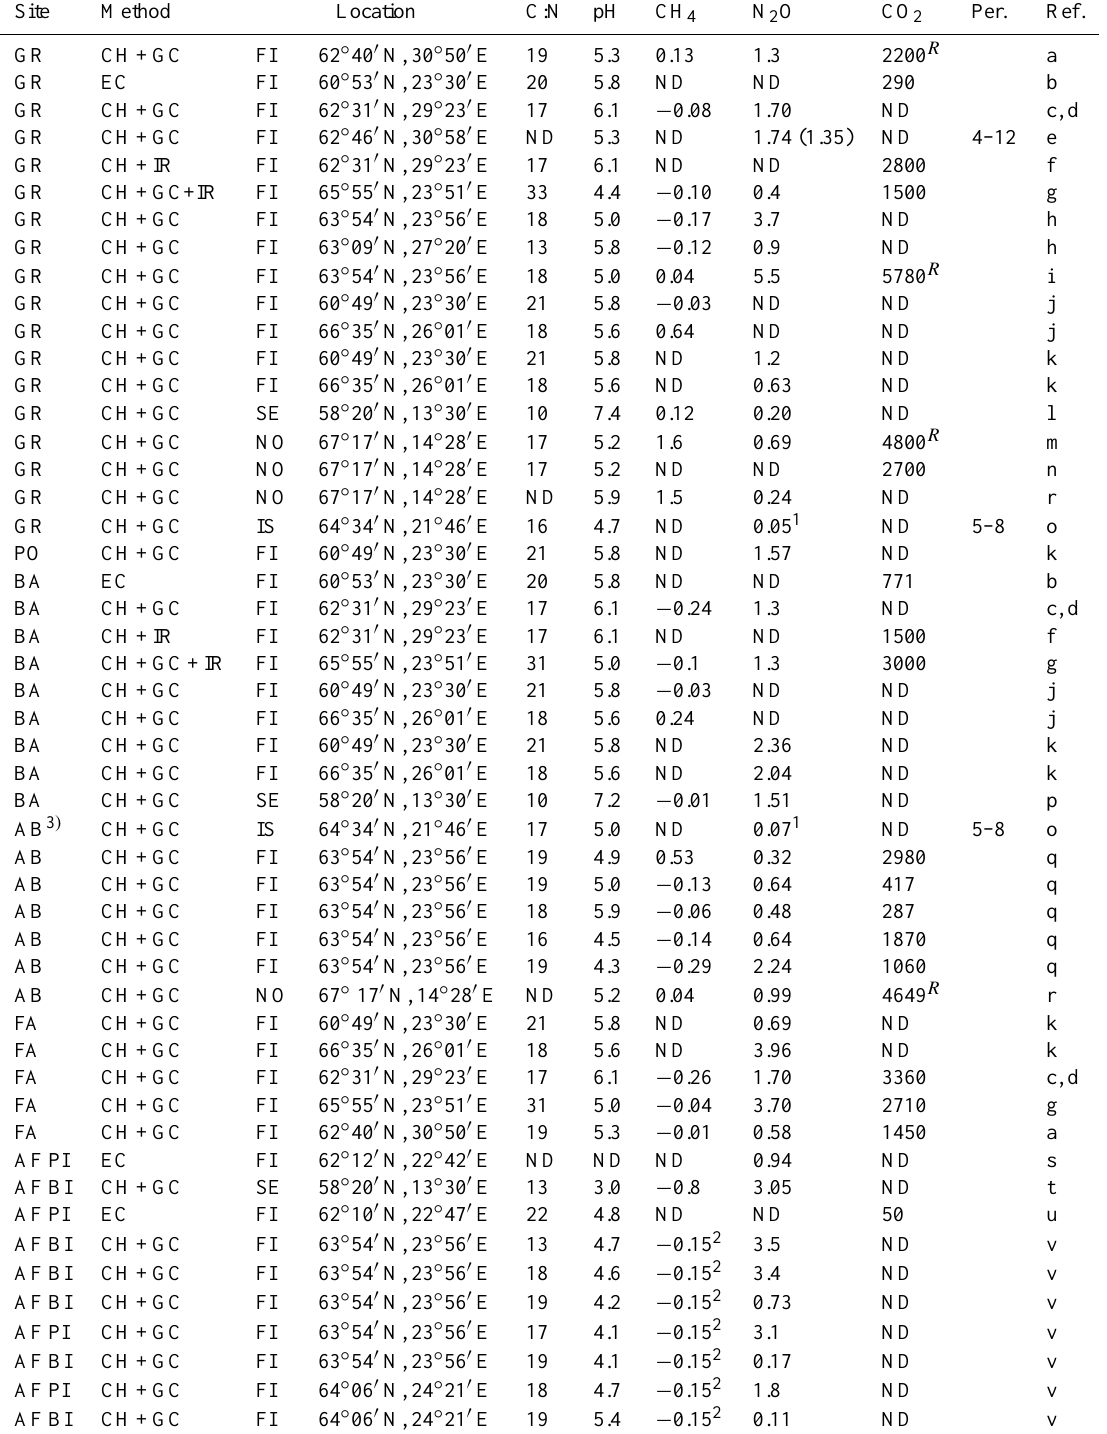
Table 3. Annual emissions of CH 4 (gm − 2 yr − 1 ), N 2 O (gm − 2 yr − 1 ) and net ecosystem CO 2 exchange (gm − 2 yr − 1 , R =only soil res- piration) from drained peatlands used for agriculture (GR=grass, BR=barley, PO=potato, CA=carrot, AB=abandoned with vegetation, FA=fallow without vegetation, AF=afforested with pine – PI – birch – BI – or alder – AL), in the Nordic countries (DK=Denmark, FI=Finland, IS=Iceland, NO=Norway, SE=Sweden). A negative value indicates uptake, a positive value indicates emission. Methods are CH=chambers, GC=gas chromatograph, IR=infra-red analyzer and EC=eddy covariance method. If annual emission is estimated based on seasonal results the original measuring period (months from-to) is shown in column “Per.” and the original emission value for that period in